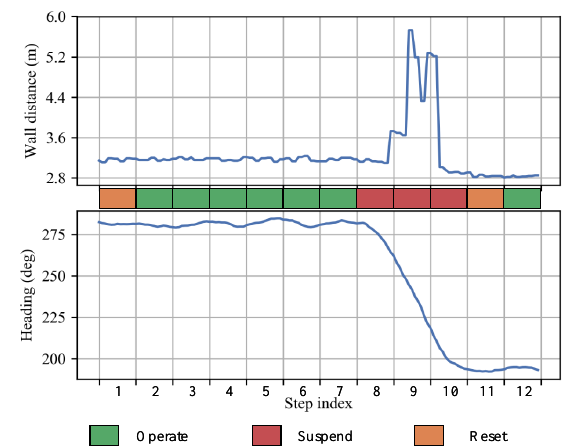
Figure 4. Illustration of the operation indicator assignment strategy. The plots show wall distance observations (above) and heading orientations (below) of several steps around a corner in a typical trajectory. Suspend is assigned to corner steps where heading increment θ n > threshold T θ . Reset is assigned to the beginning N i steps of each non-corner segment. Other steps are indicated as Operate